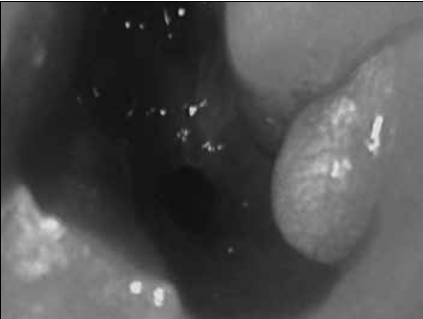
Figure 1. Surgical